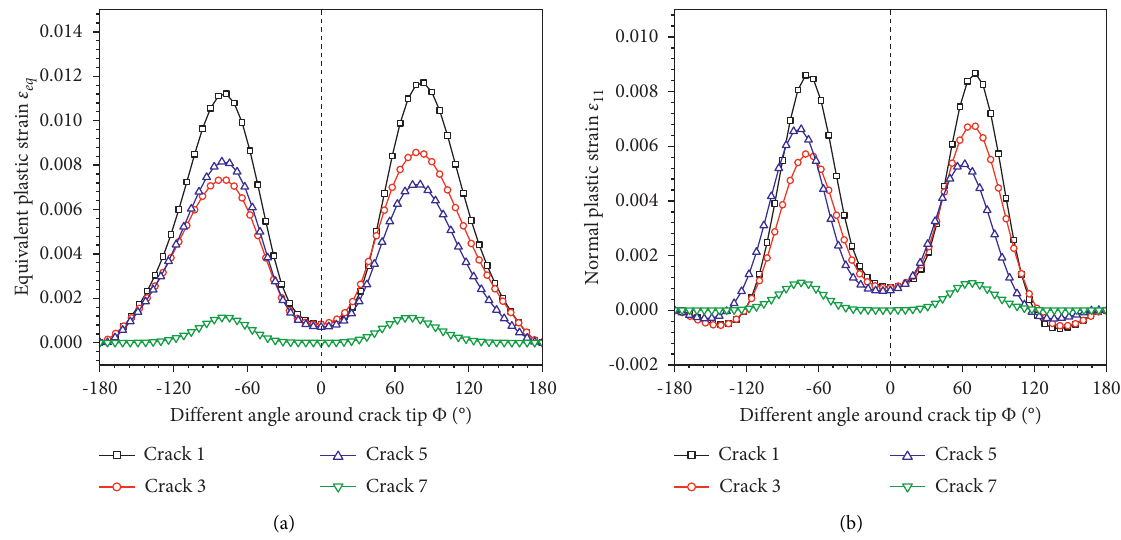
Figure 10: The strain curve at the crack tip of the noninterface. (a) Equivalent plastic strain and (b) normal plastic